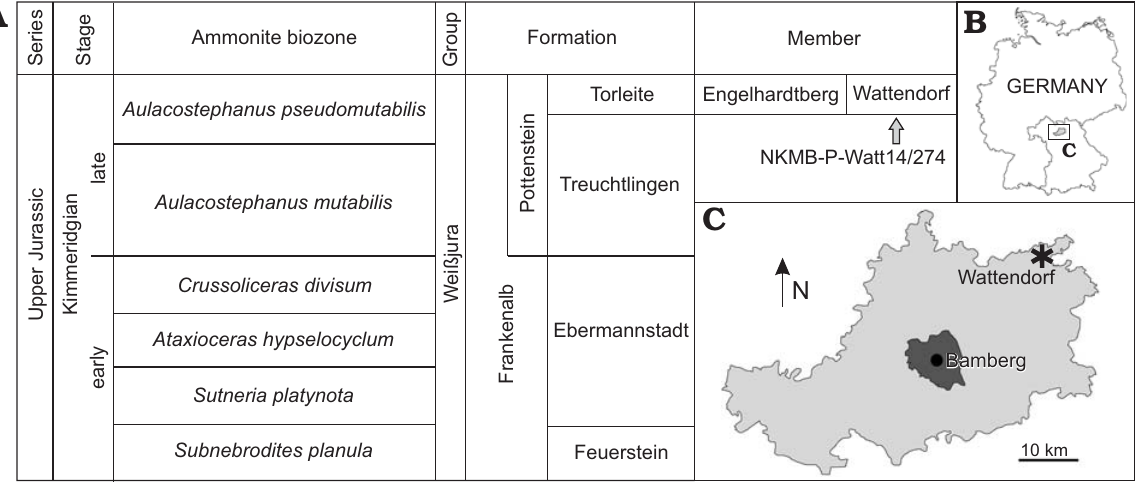
Fig. 2. A . Reduced stratigraphic table of the Kimmeridgian rock units of the northern Franconian Jurassic, based on Niebuhr and Pürner (2014). B , C . Maps showing the locality of NKMB-P-Watt14/274 at Wattendorf (asterisk) within the Bamberg district and its placement in